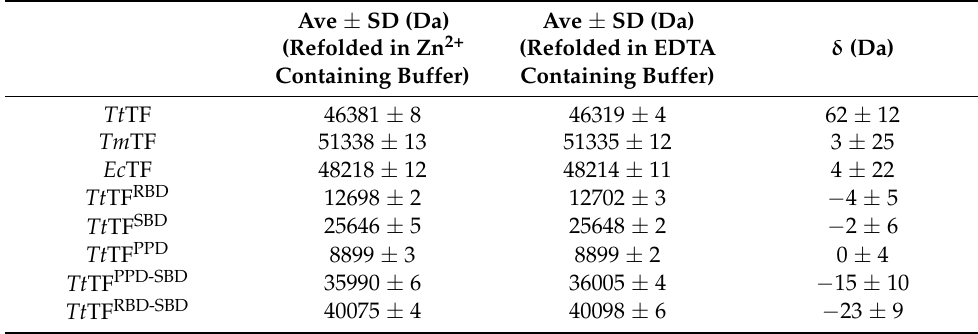
Figure 1. MALDI-TOF-MS analysis for Tt TF, Tm TF, and Ec TF prepared in the absence and presence of Zn 2+ . The overlapped mass spectra for Tt TF ( A ), Ec TF ( B ), and Tm TF ( C ) refolded in the buffer containing Zn 2+ (red) or EDTA (black). The expanded views are displayed at the top right corner. The theoretical molar masses of Tt TF (EDTA), Ec TF (EDTA), and Tm TF (EDTA) are 46,313 Da, 48,193 Da, and 51,330 Da, respectively. The theoretical molar mass of Zn 2+ is 65 Da. The absolute values of the difference between the experimental molar masses (| δ MM |) of TFs (Zn 2+ ) and TFs (EDTA) are displayed in the below expanded views. a.u., arbitrary unit. Table 1. Summary of MALDI-TOF-MS experimental results for TtTF and its domains in the pres- ence/absence of Zn 2+ . The values are rounded to